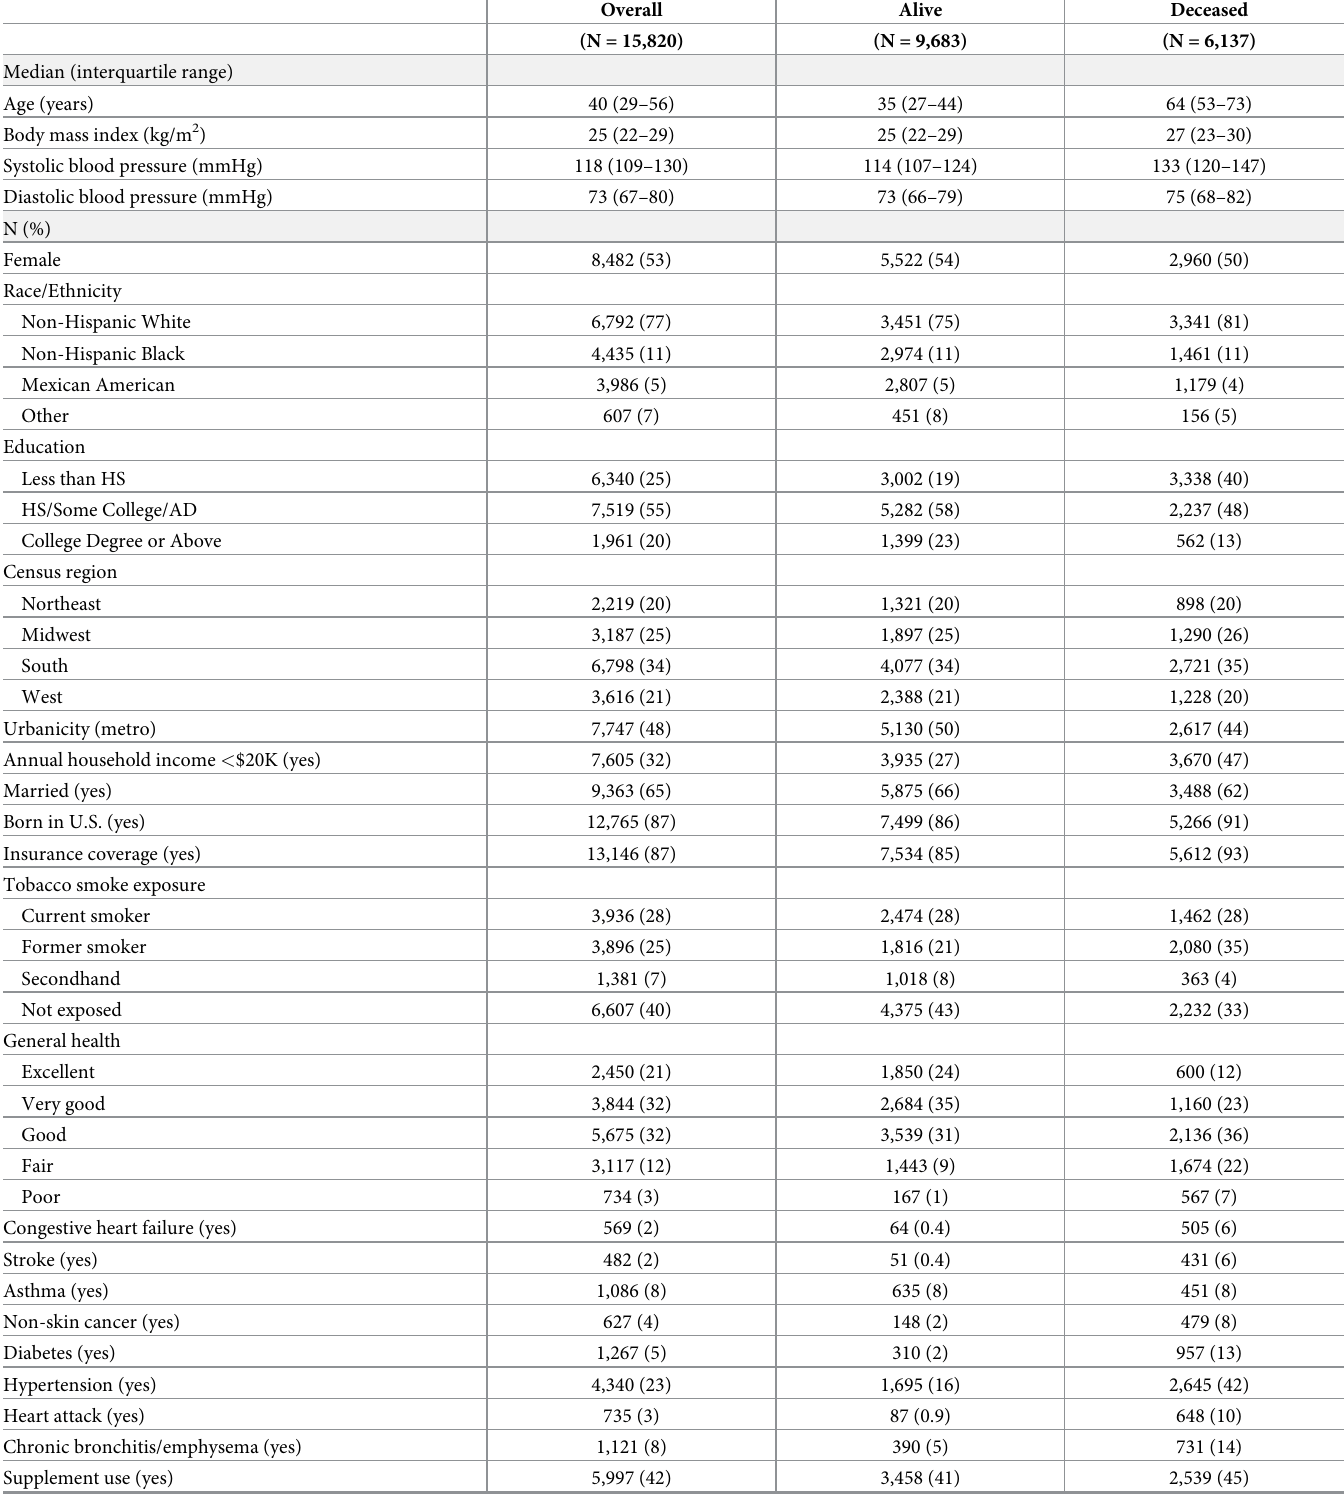
Table 1. Descriptive characteristics of the National Health and Nutrition Examination Survey III analytic population a